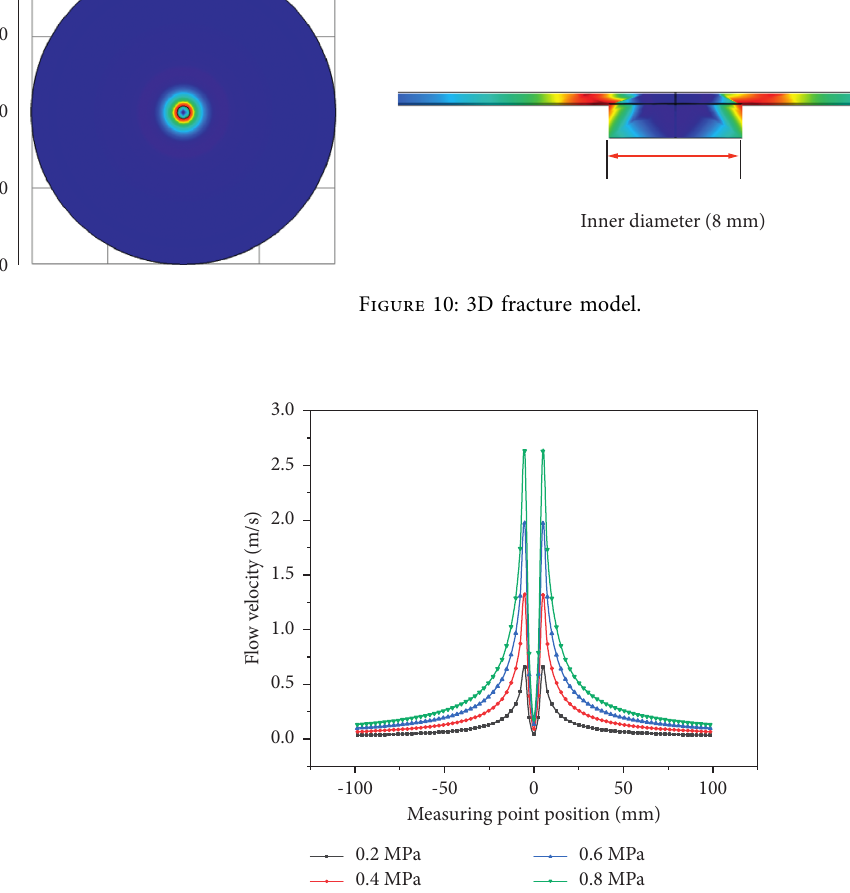
Figure 11: The variation curve of velocity along radial distance under different hydraulic pressure